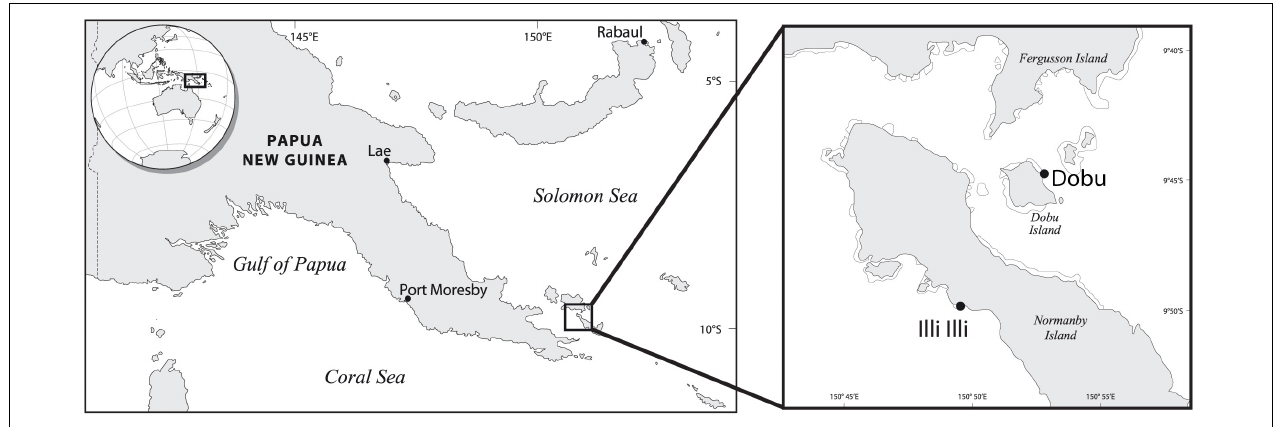
FIGURE 1 | Study site locations in Papua New Guinea (adapted from Fabricius et al.,